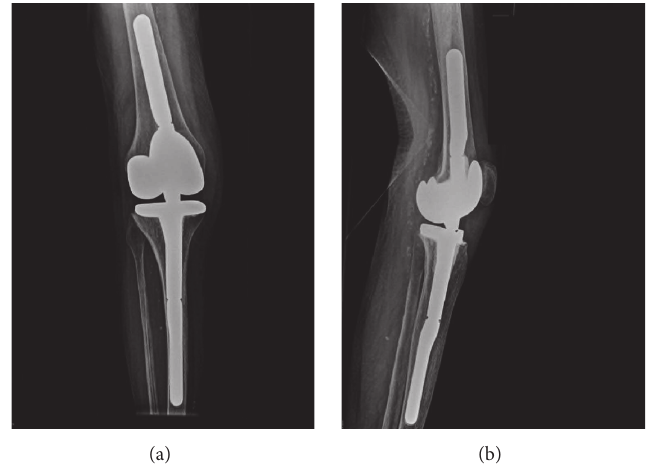
Figure 4: Postoperative standing X-rays of the knee: anteroposterior (a) and lateral (b) view. Tibiofemoral alignment of 6 ∘ valgus.